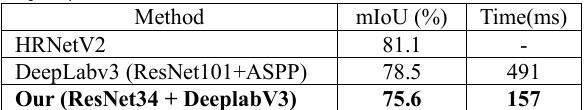
Table 4. Cityscapes validation set results for 2,048×1,024 input on